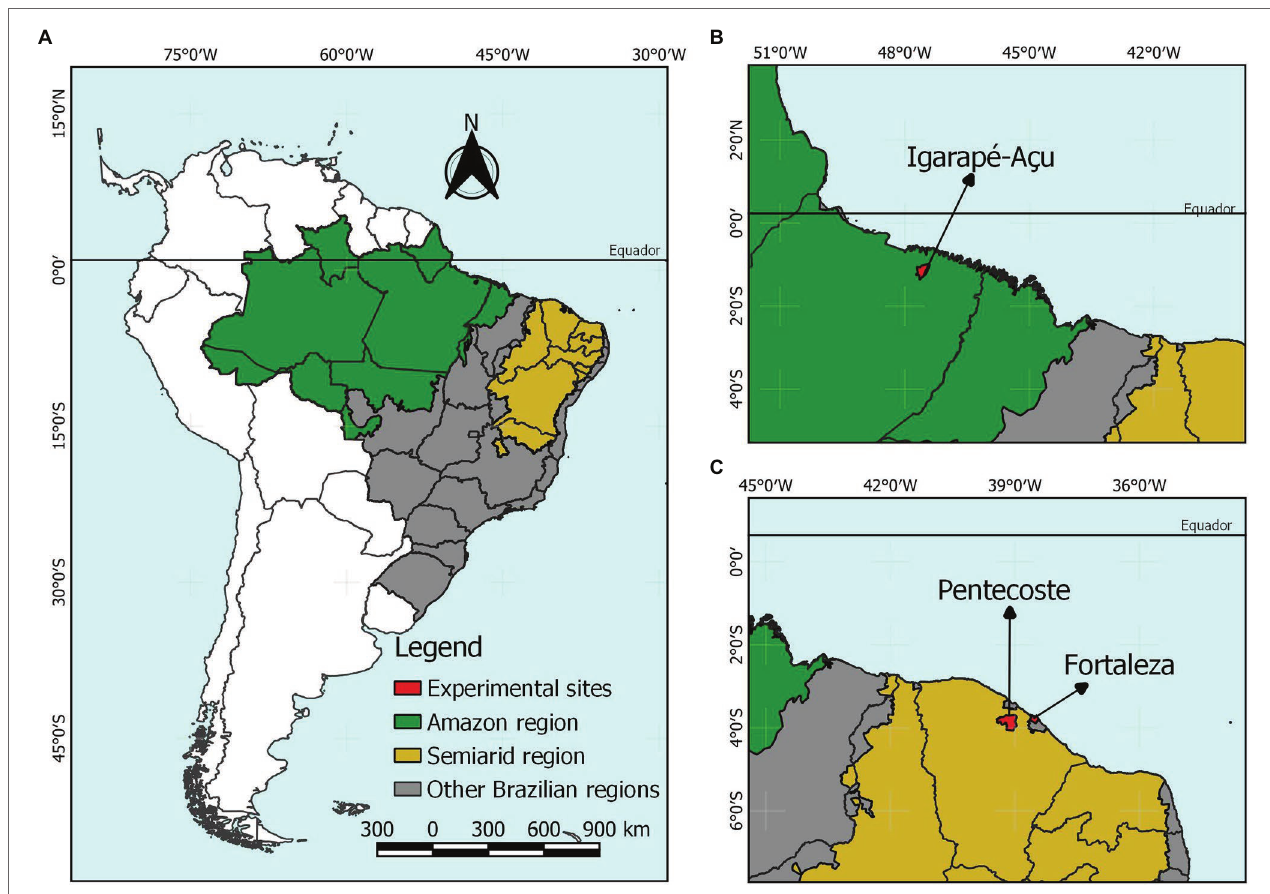
FIGURE 1 | Location map of experimental sites. (A) Representation of the delimitation of the humid tropical region of the Amazon and the semi-arid region in Brazil. (B) Location of the Igarapé-Açu experimental site. (C) Location of the experimental sites of Fortaleza and